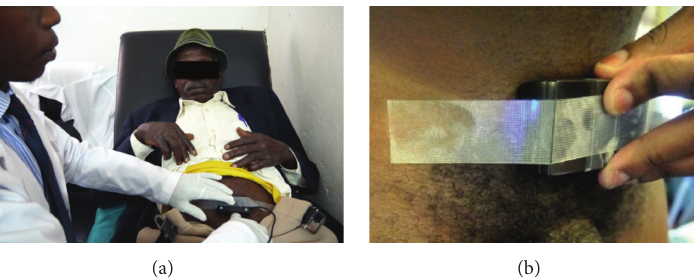
Figure 2: Positioning the device over the bladder using the bony landmark of the symphysis pubis (a); the device taped in place and steadied against the skin by the subject prior to spontaneous voiding